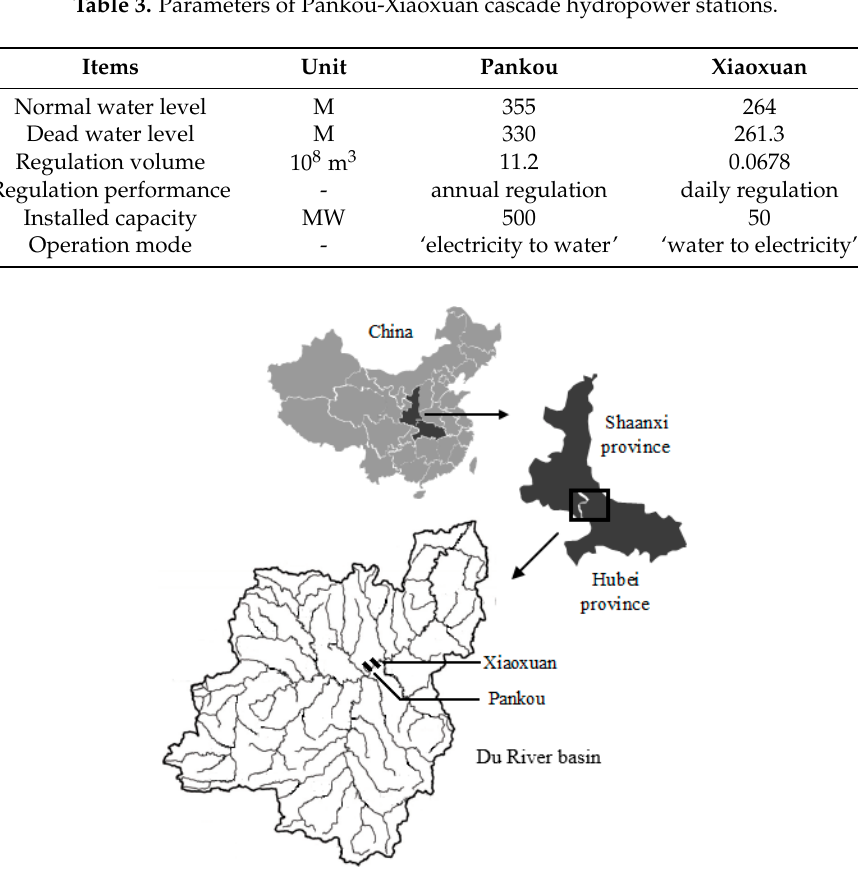
Figure 7. The location of Pankou-Xiaoxuan cascade reservoirs.